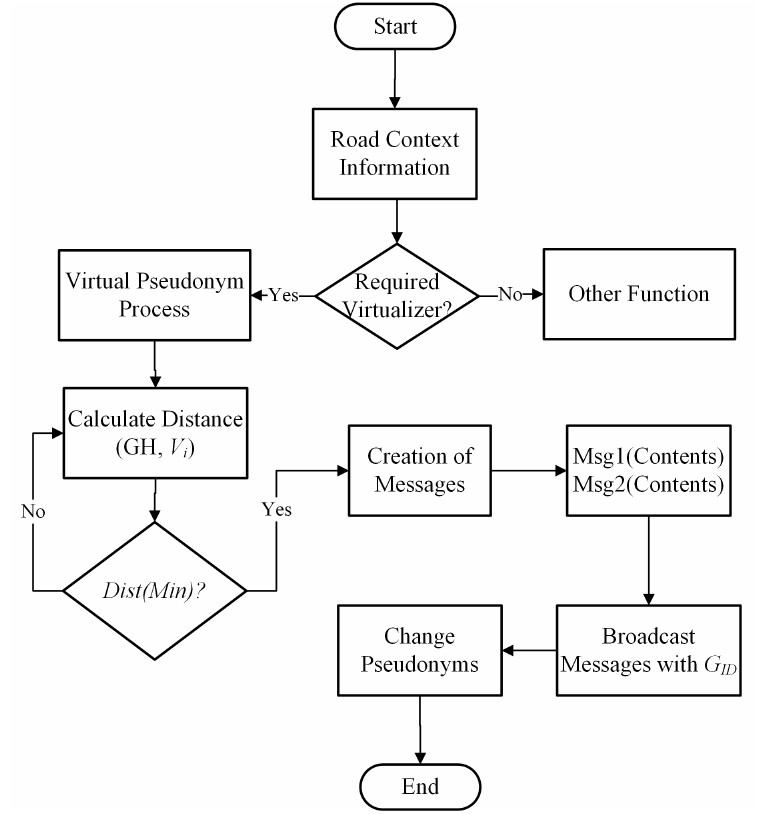
Figure 8. Virtual pseudonym update